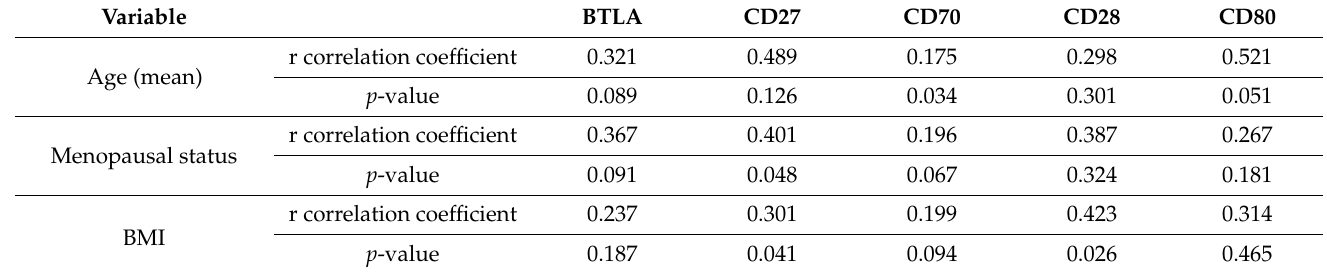
Table 10. The correlations between serum concentrations of BTLA, CD27, CD70, CD28 and CD80 and age, menopausal status and BMI, presented as Spearman ranges‚ r correlation coefficient, p -value. Variable